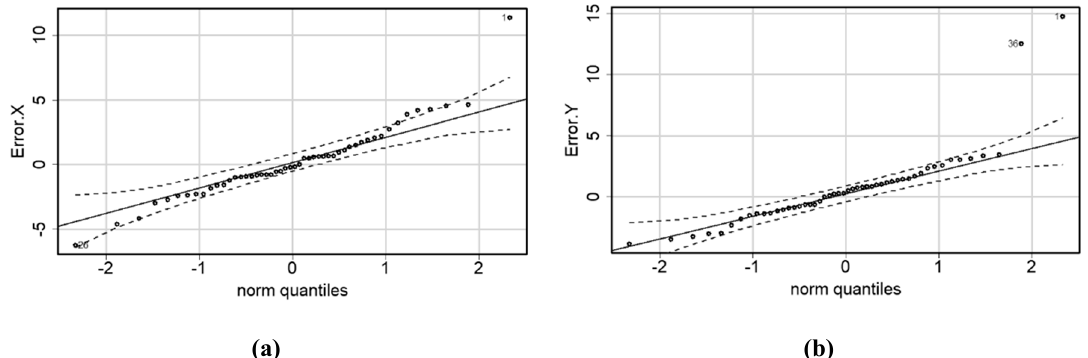
Figure 7 . QQ-plots corresponding to the variables calculated with the 50 GCP dataset: ( a ) error X; ( b ) error Y.